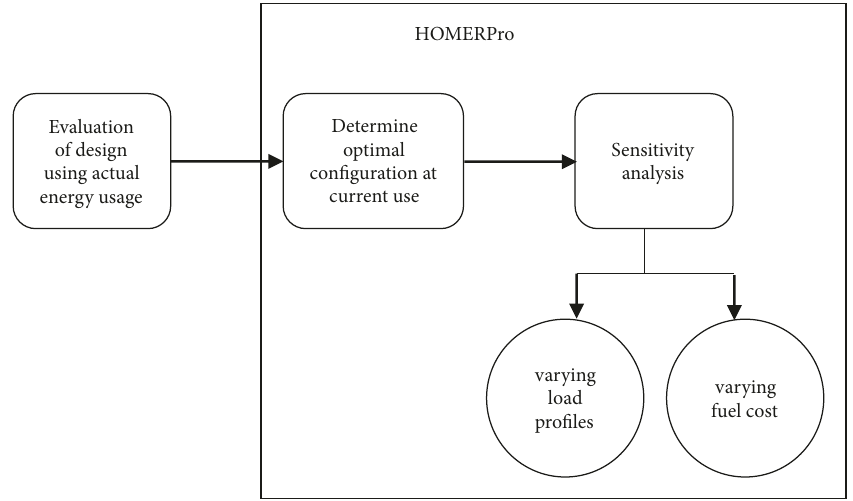
Figure 1: Research